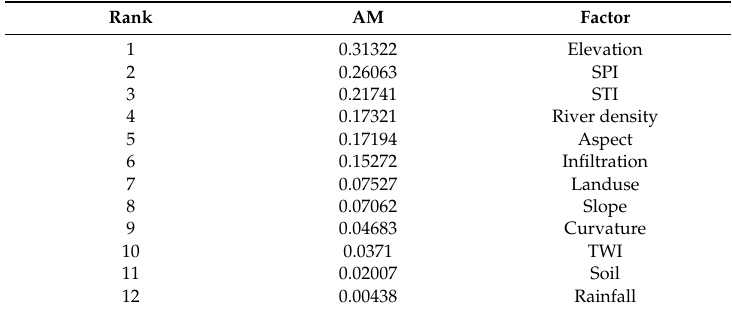
Table 1. Factor ranks extracted using correlation-based feature selection method. Rank AM